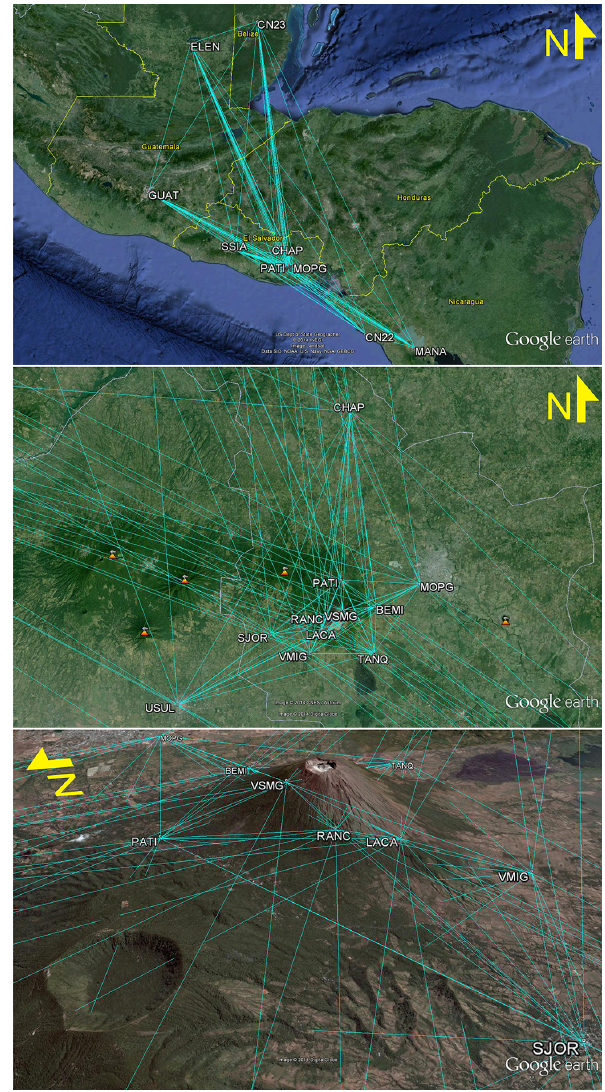
Figure 8. GPS network and baselines processed weekly for this work, from regional to local